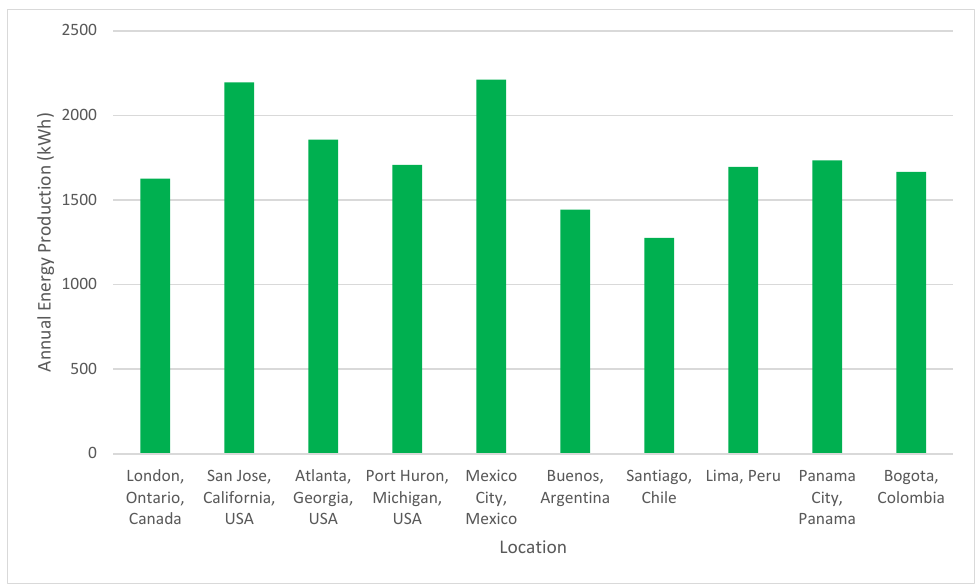
Figure 5. Annual PV electrical generation in kWh for the PV systems located in representative cities for each country evaluated.